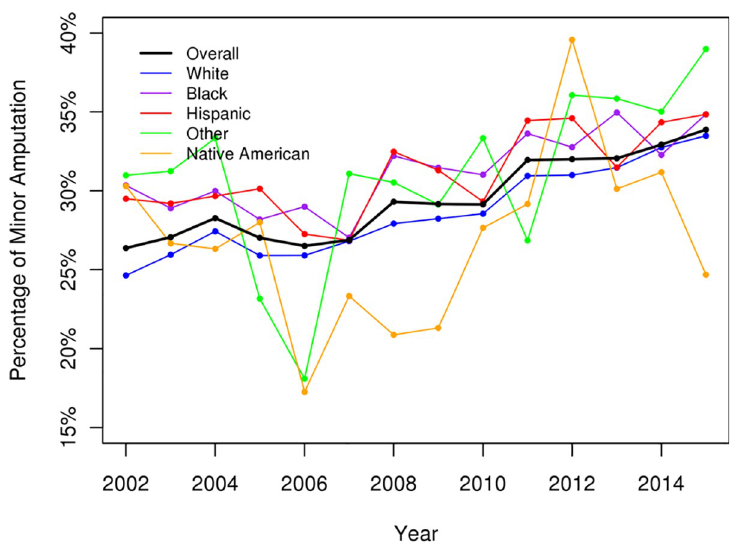
Fig 3. Percentage of minor amputation for diabetic foot infection (overall p <